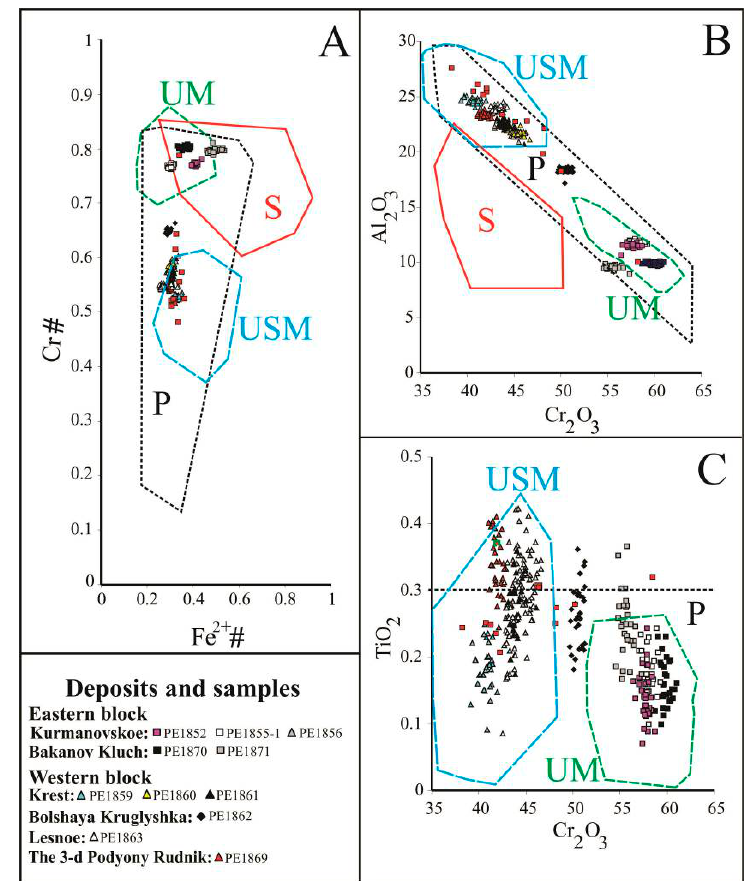
Figure 6. Composition of unaltered chromite from the Alapaevsk chromitite. ( A ) Variation of the chromium number, Cr# = Cr/(Cr + Al), and bivalent iron number, Fe 2+ # = Fe 2+ /(Fe 2+ + Mg); ( B ) negative correlation of Al 2 O 3 versus Cr 2 O 3 ; ( C ) variation of Cr 2 O 3 and TiO 2 . P = field of podiform chromitites; S = field of stratiform chromitites; UM = field of the Uralian chromitites hosted in the ophiolitic mantle; USM = field of the Uralian chromitites hosted in the supra-Moho cumulates [6,18–20]. Red square = literature data from [21].